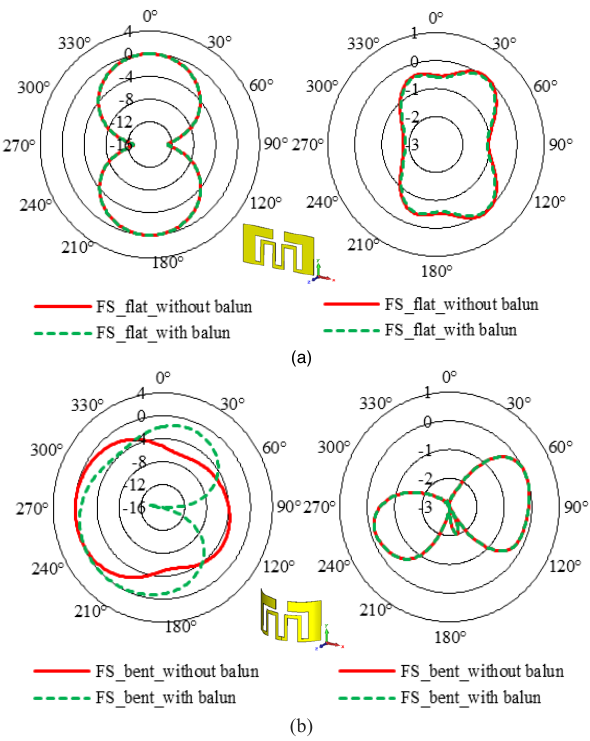
FIGURE 3. Simulated radiation patterns of (a) flat and (b) bent flexible antenna with and without a Balun in free-space (FS) at resonance frequencies in f =0° H-plane (left) and f =90° E-plane (right).